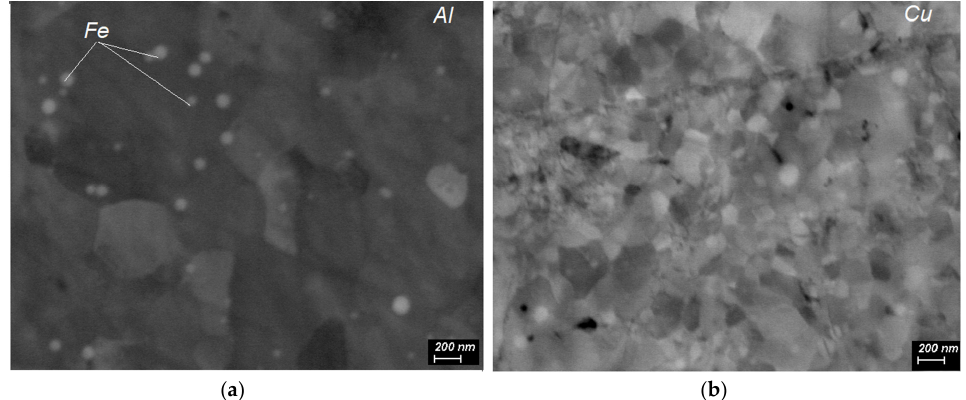
Figure 2. SEM images (back-scattered electrons) of the microstructure after two ECAP passes (Route B C ) and annealing. ( a ) Aluminium core; ( b ) copper sheath. and annealing. ( a ) Aluminium core; ( b ) copper